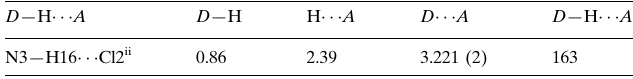
Hydrogen-bond geometry (A˚ , (cid:2)